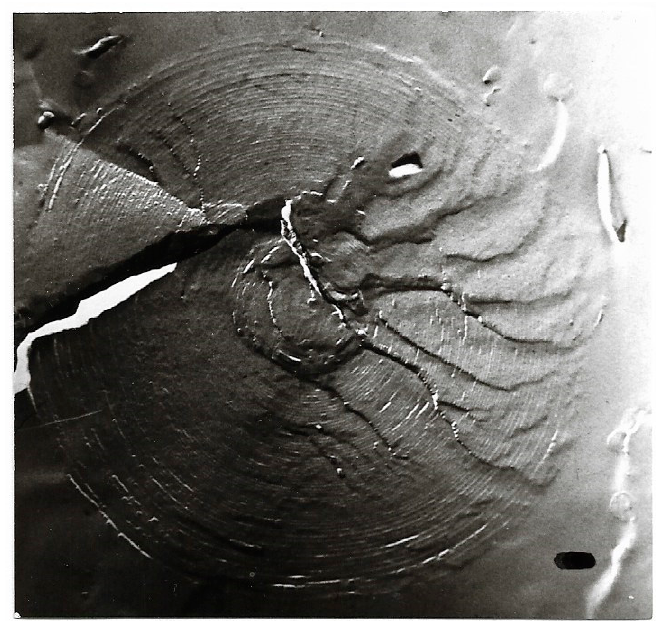
Figure 10. Freeze-fracture electron microscopy of a giant multilamellar, densely packed structure under poorly hydrated lyotropic condition; magnification × 54,000; bar = 100 nm. The formation resembles - though spherical - the P phase of GDNT in [58–60]. Electron micrographs of Figures 5–10 had been presented in [13,56,61].